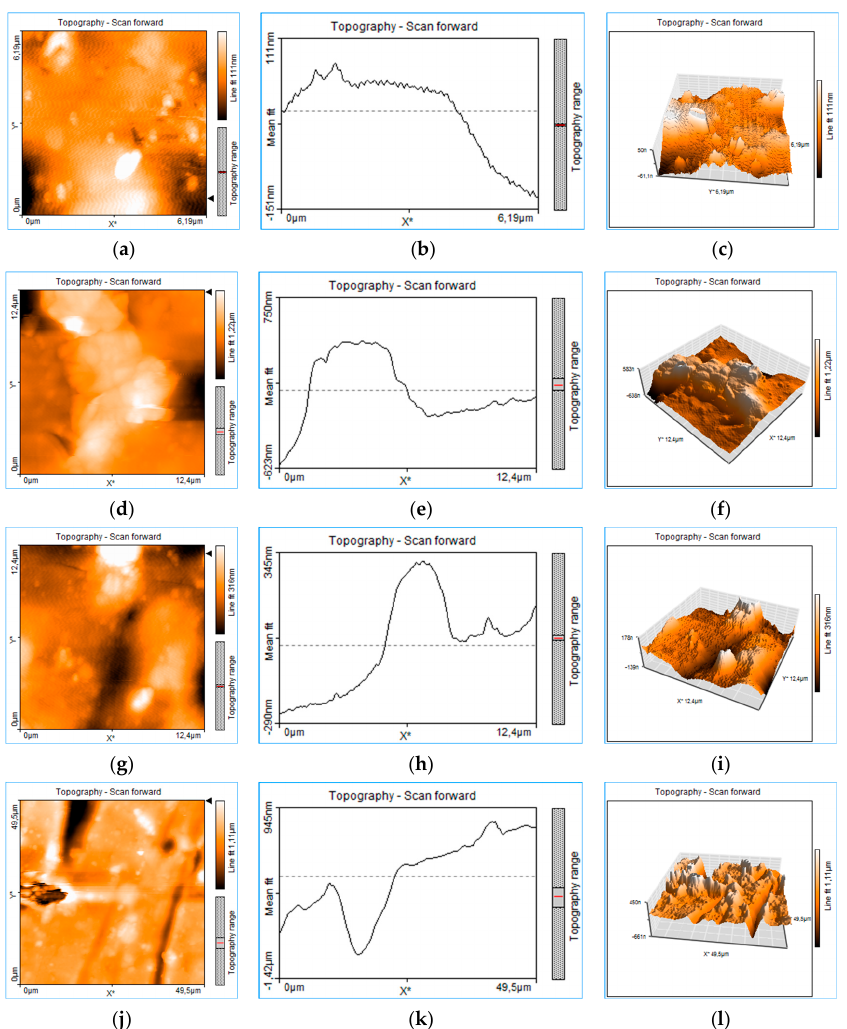
Figure 3. Roughness analysis of the PLD-HMP-STK thin film: 2D plots of surface topography ( a , d , g , j ), 1D plots of thickness topography ( b , e , h , k ) and 3D plots in volume topography ( c , f , i , l ).